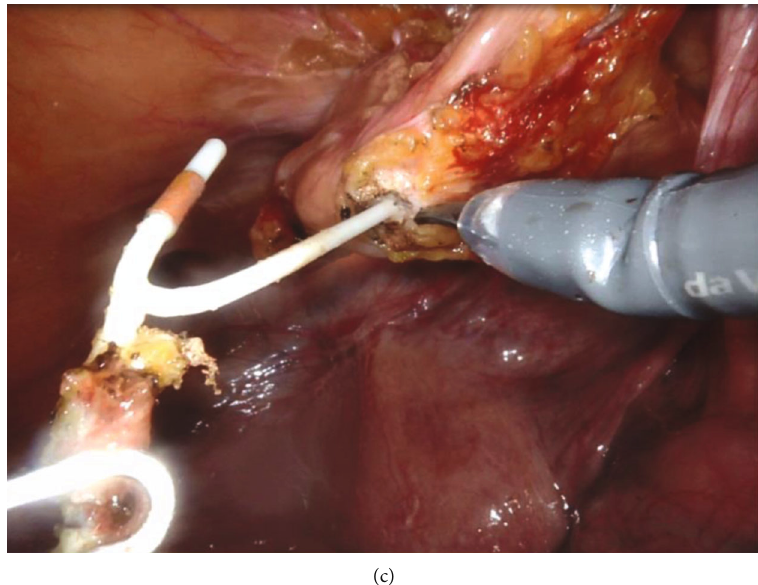
Figure 2: (a) Scarred peritoneum overlying the right anterior bladder dome at site of likely IUD translocation (arrow). (b) After partially entering the space of Retzius, the extravesical part of the IUD was identi fi ed. (c) A subcentimeter cystotomy was made to free the intravesical portion of the IUD and facilitate removal of the device.